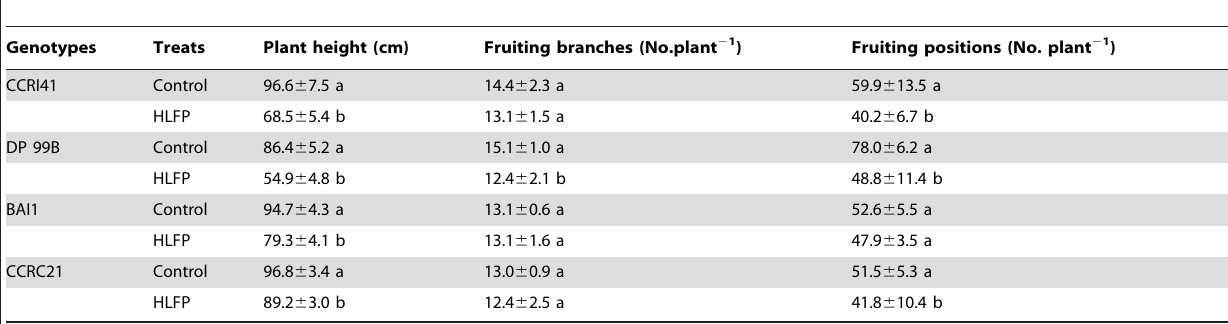
Table 1. Plant heights, numbers of fruiting branches, and numbers of fruiting positions for four cotton genotypes that were subjected to mechanical stress caused by hanging labels from the petioles (HLFP) of every white flower in the field.